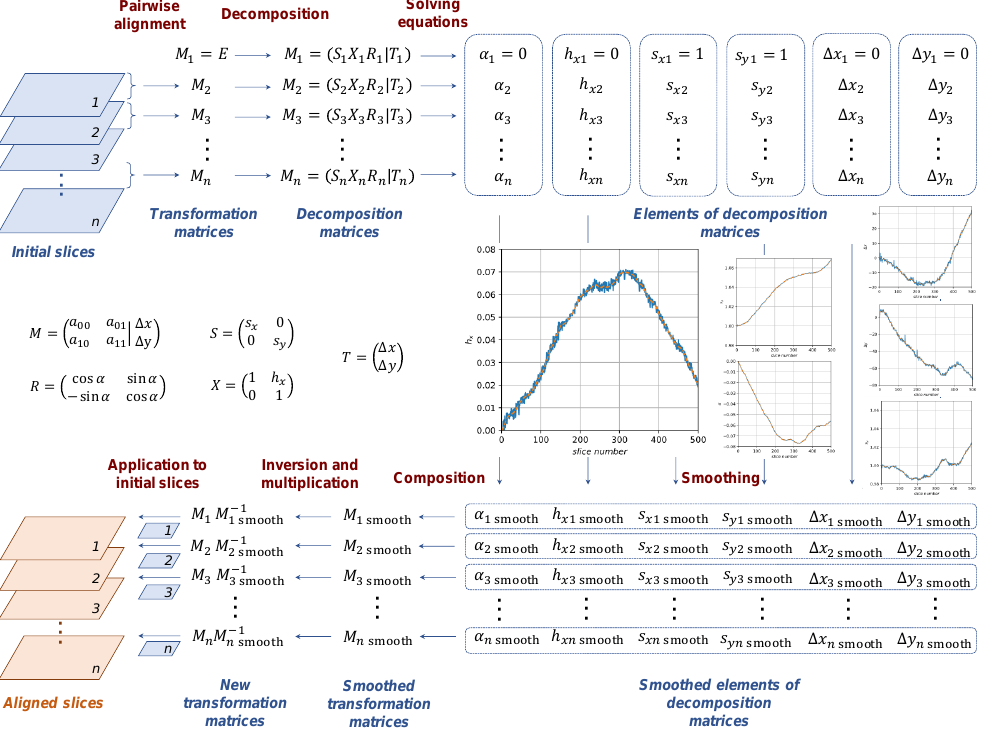
Figure 10. A scheme of the proposed algorithm.